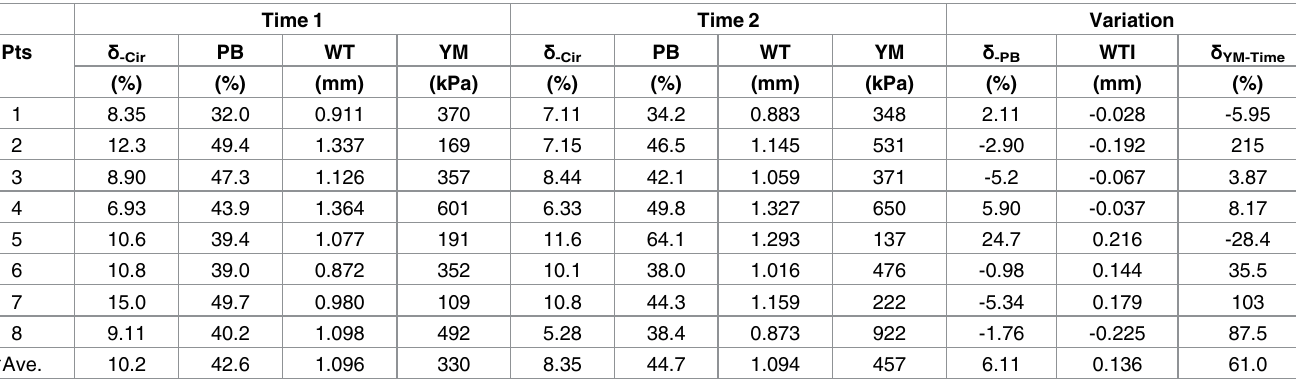
Pts is patients. PB is plaque burden. WT is wall thickness. WTI is wall thickness increase. * : The average δ YM-Time, δ PB and WTI values were calculated using absolute values. c 2 = 0 and D 2 = 2 for all cases. Due to axial shrink applied to the 3D thin-layer model, some C-Shrink values in 3D thin-layer model were